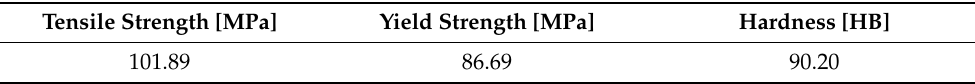
Table 1. The basic mechanical properties of the selected AlCu4Mg alloy.